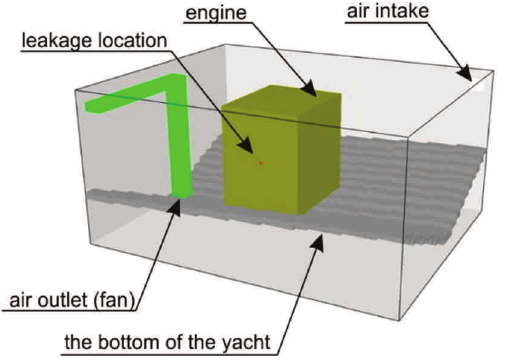
Fig. 7. Diagram of the engine